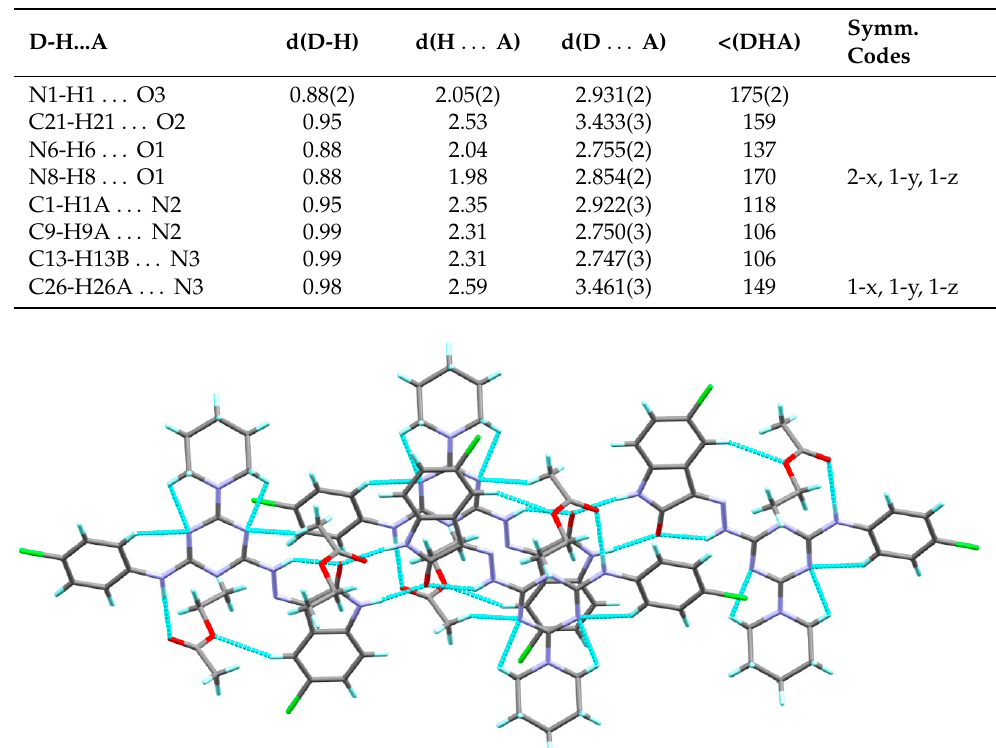
Figure 3. Molecular packing showing the intra- and inter-molecular C-H…O and C-H…N interac- tions.